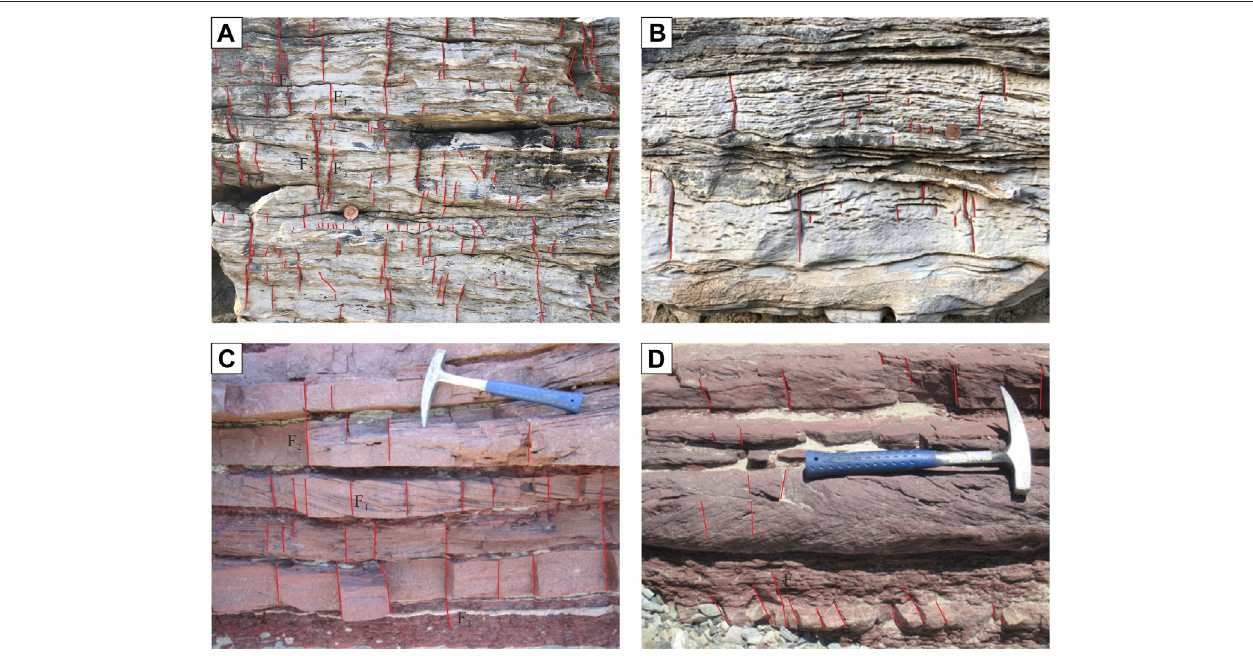
FIGURE 9 | Outcrops with delaminated fractures. (A) Carbonate sequence with similar lithology and different thicknesses; (B) carbonate sequence with different lithology; (C) sandstone sequence with similar lithology and different thicknesses; (D) sand and shale sequence. F1 - intrastratal fracture, F2 - interlaminar fracture, and F3 - interlaminar extending fracture.